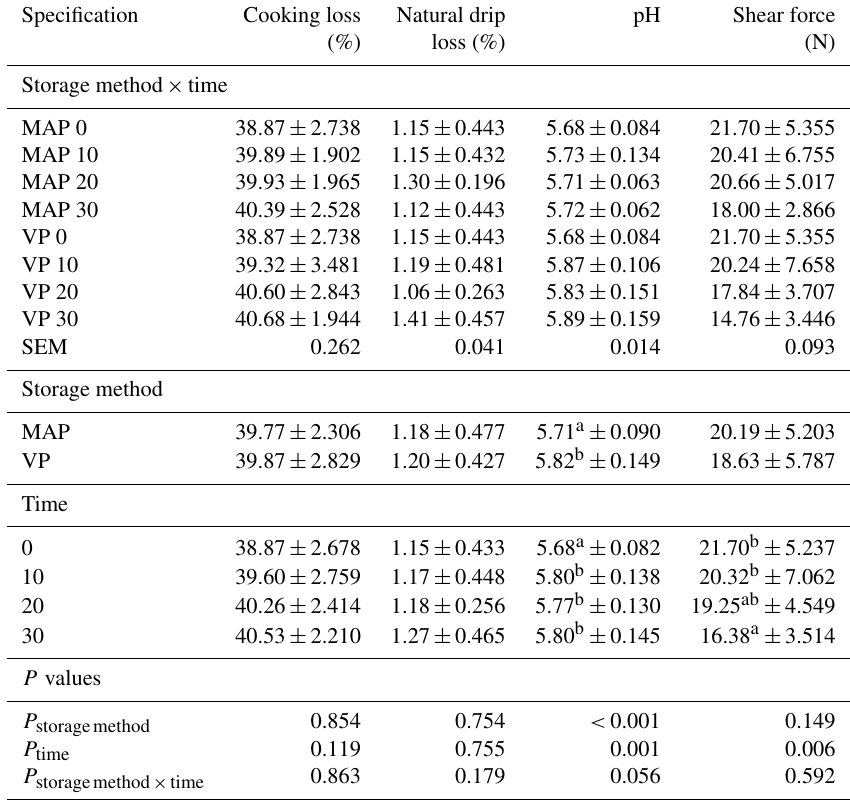
Table 3. Effect of vacuum packaging and modified atmosphere packaging on physicochemical parameters of lamb meat during storage at 4 ◦